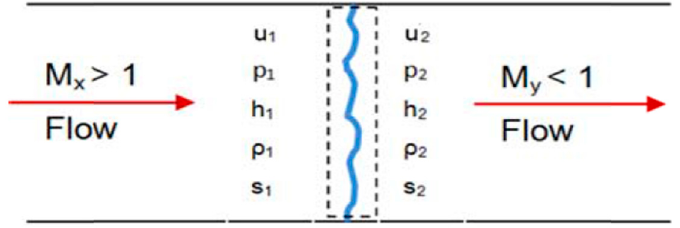
Figure 3. Illustrations of different stages adapted from Blanco [38], with permission from Cranfield University, 2014.